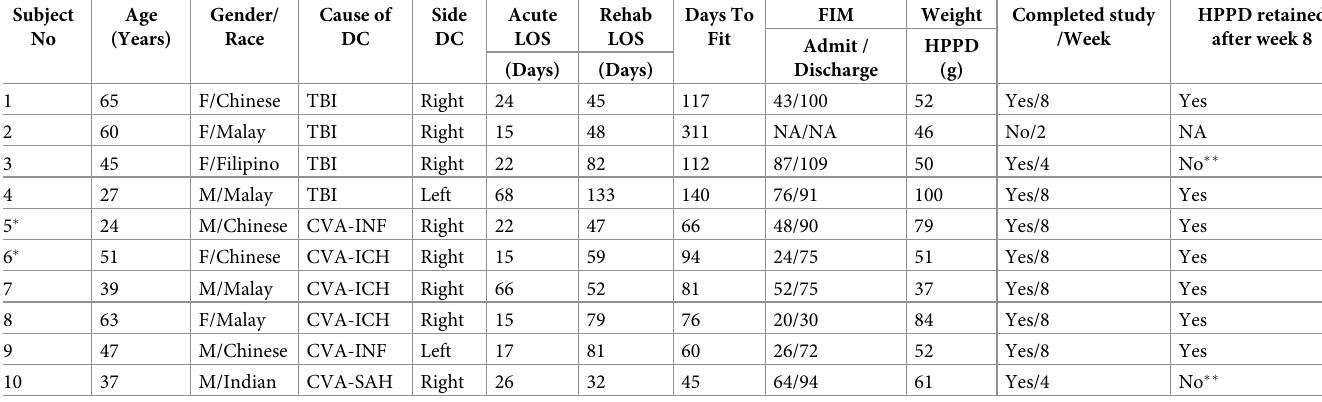
Table 1. Baseline individual demographic, clinical and HPPD characteristics (N =